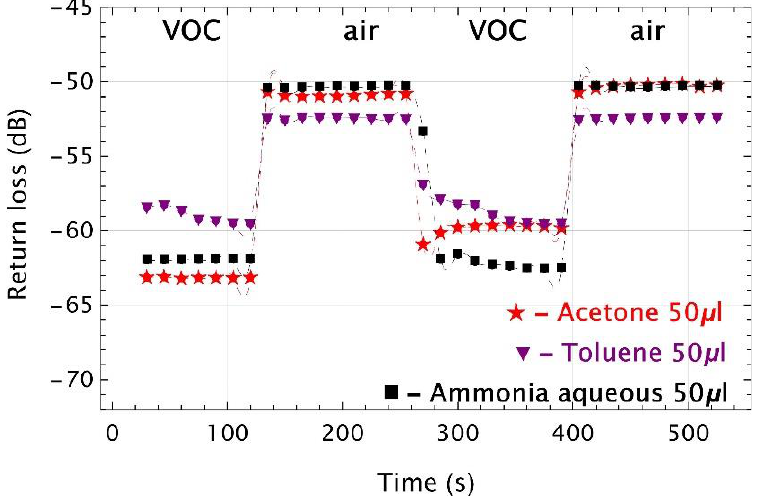
Figure 13. Time responses of UV microtips twice inserted into and removed from the vial filled with acetone (red), toluene (violet), and ammonia aqueous (black). Colored plot markers indicate experimental points, while the dashed lines are data interpolations. All VOCs are in a volume of 50 μL.